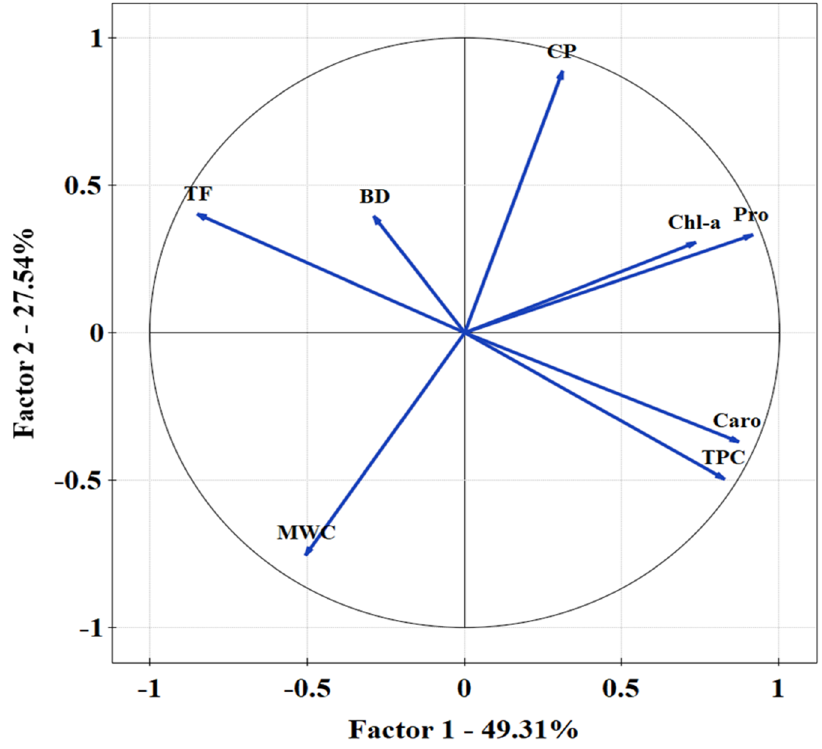
Figure 4. Principal component analysis for water parameters in soil substrate and biochemical properties measured in T. officinale . Kaiser-Mayer-Olkin ratio = 0.704; Barlett’s test p < 0.001.